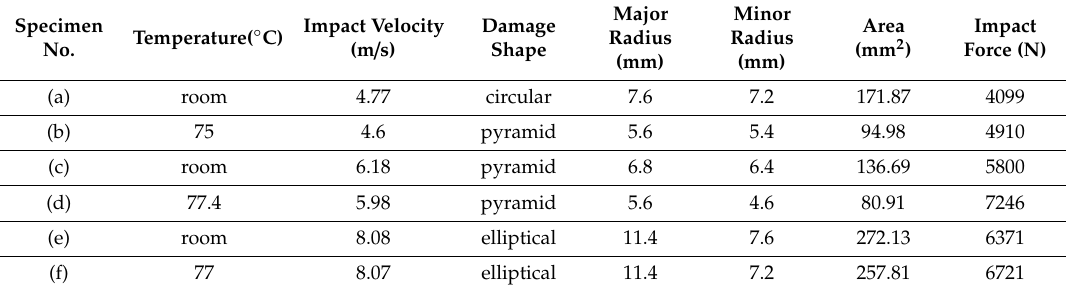
Figure 13. Damage area of the impacted GLARE specimens for ( a ) room temperature and 2 m DH, ( b ) 75 °C and 2 m DH, ( c ) room temperature and 3 m DH, ( d ) 77.4 °C and 3 m DH, ( e ) room temperature and 4 m DH, and ( f ) 77 °C and 4 m DH; alphabetic specimen order corresponds to the impact test condition in Table 5; rows ( i ), ( ii ), ( iii ), and ( iv ) stand for rear view, front view, side view, and c-scan image, respectively; the legend indicates the attenuation of ultrasonic waves in C-scan. Table 6. Experimental outcomes of low velocity impact on GLARE